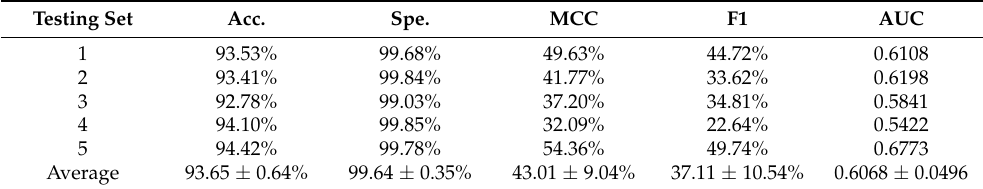
Table 1. The FFCV outcomes attained using SIPGCN in the human data set.